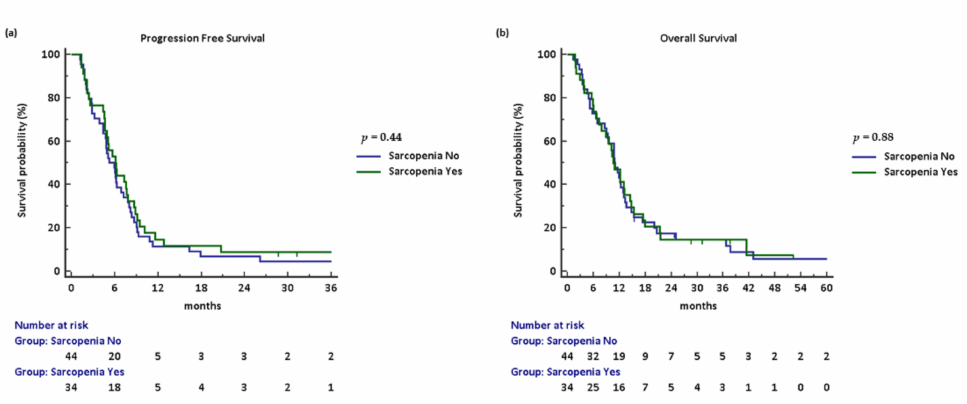
Figure A2. Kaplan–Meyer curves according to presence or absence of sarcopenia: ( a ) progression-free survival; and ( b ) overall